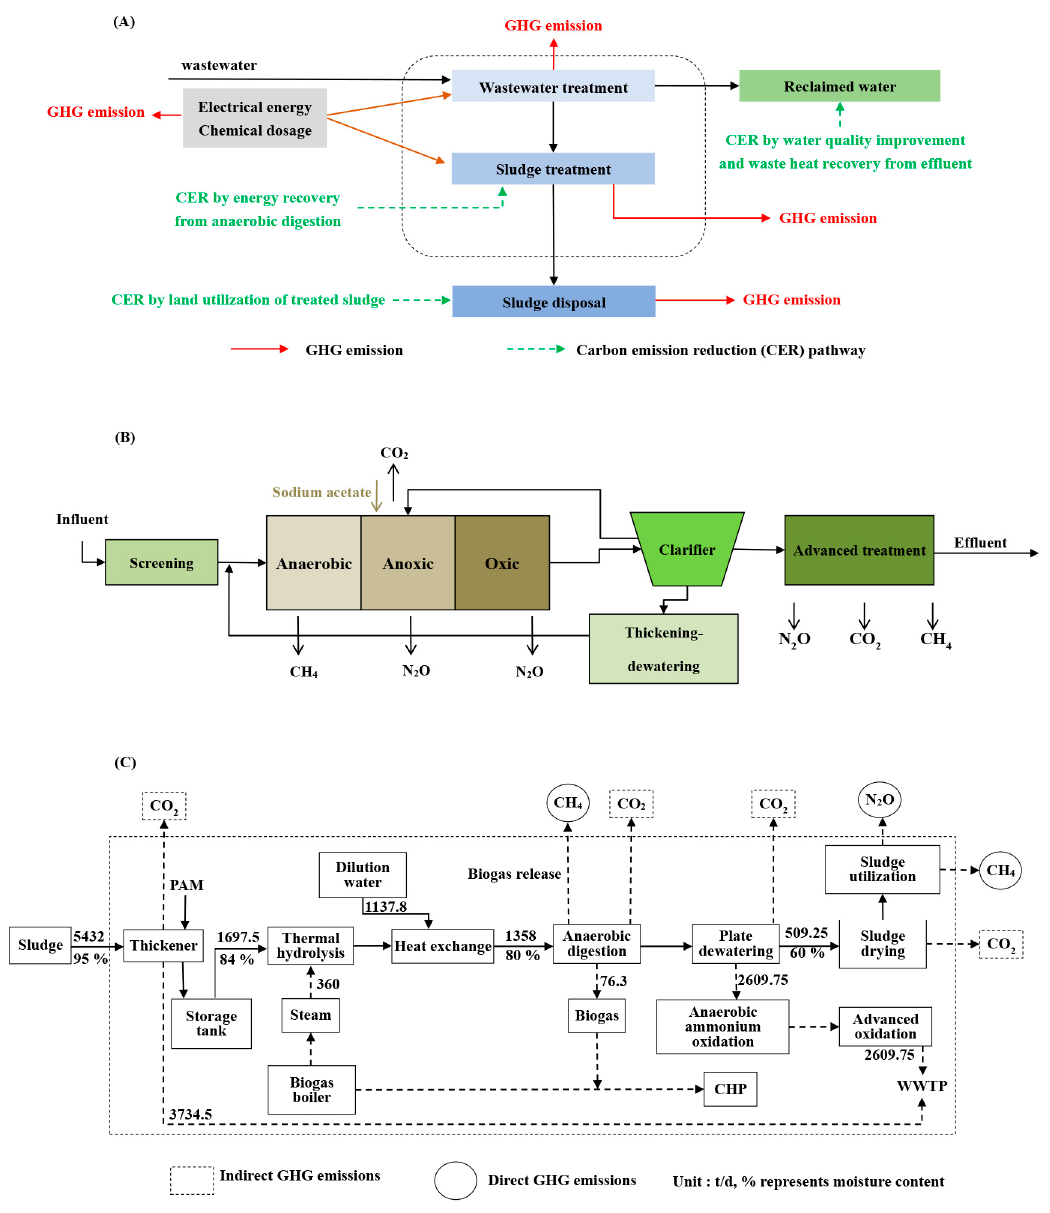
Figure 1. The system boundaries of ( A ) Gaobeidian WWTP, ( B ) the wastewater treatment process, and ( C ) the sludge treatment process for calculating the carbon